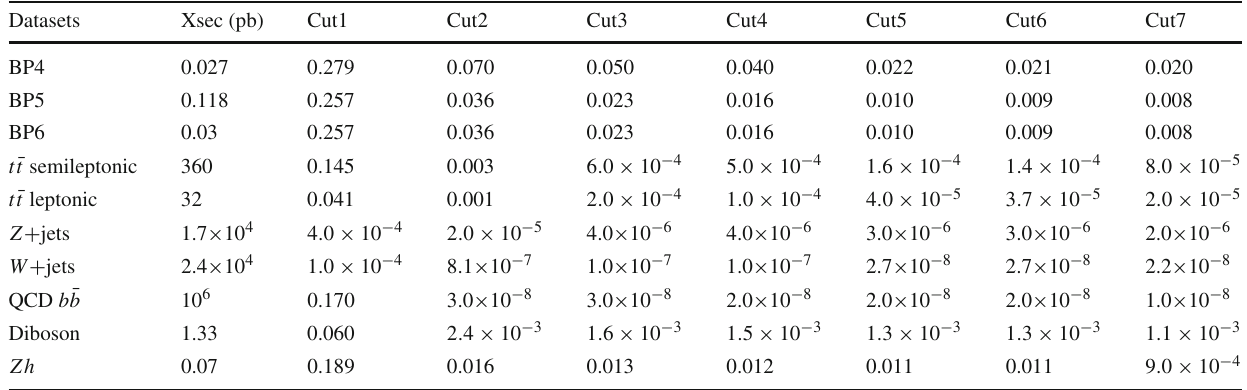
Table 5 Signal and background efficiencies in the b ¯ b + / E T final state after applying various cuts at 13 TeV. The cross-sections are calculated at NLO Datasets